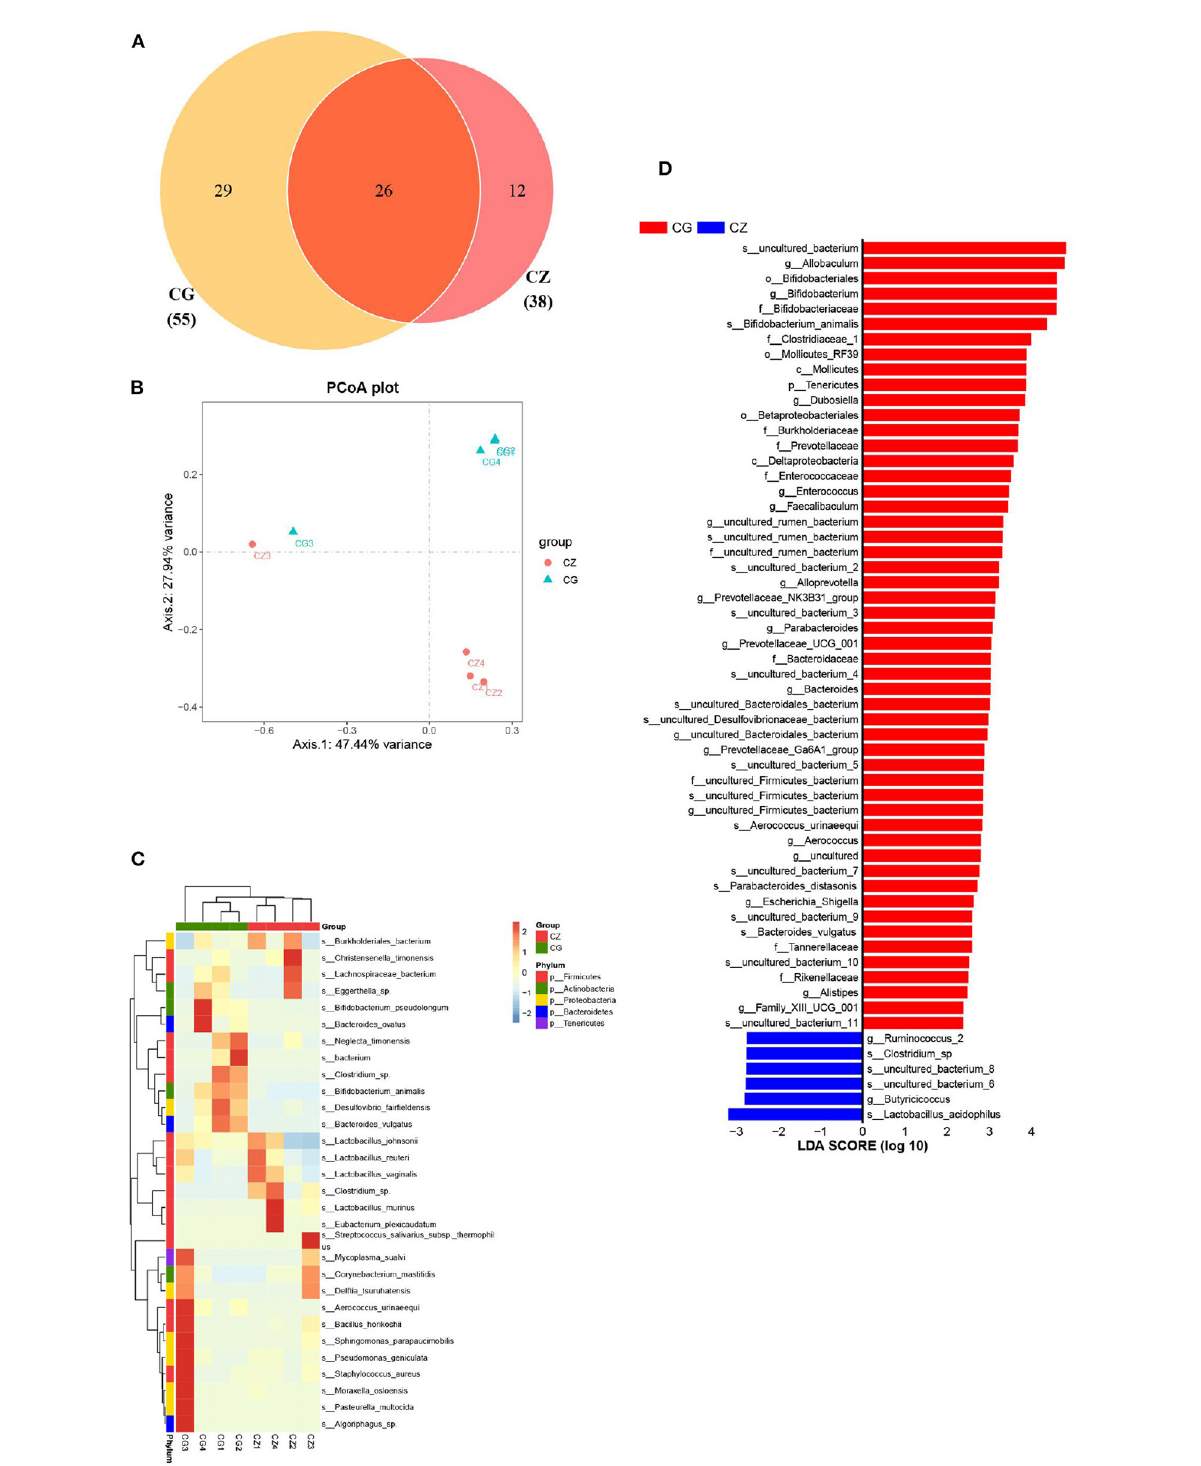
FIGURE2 The diversity, composition and key bacteria of intestinal microbiota with hypertension of liver-Yang hyperactivity syndrome induced by a high salt diet at species level. (A) Venn diagram of OTU distribution at species level. (B) Cluser analysis of PCoA based on the OTUs of taxonomic bacterial species. (C) Heatmap clustering of community species abundance at species level, and the closer the color is to red, the higher the abundance. (D) Cladogram generated from the LEfSe analysis indicating the phylogenetic distribution from family to species of the microbiota (LDA score ≥ 2, P < 0.05). CZ, normal group, CG, hypertensive